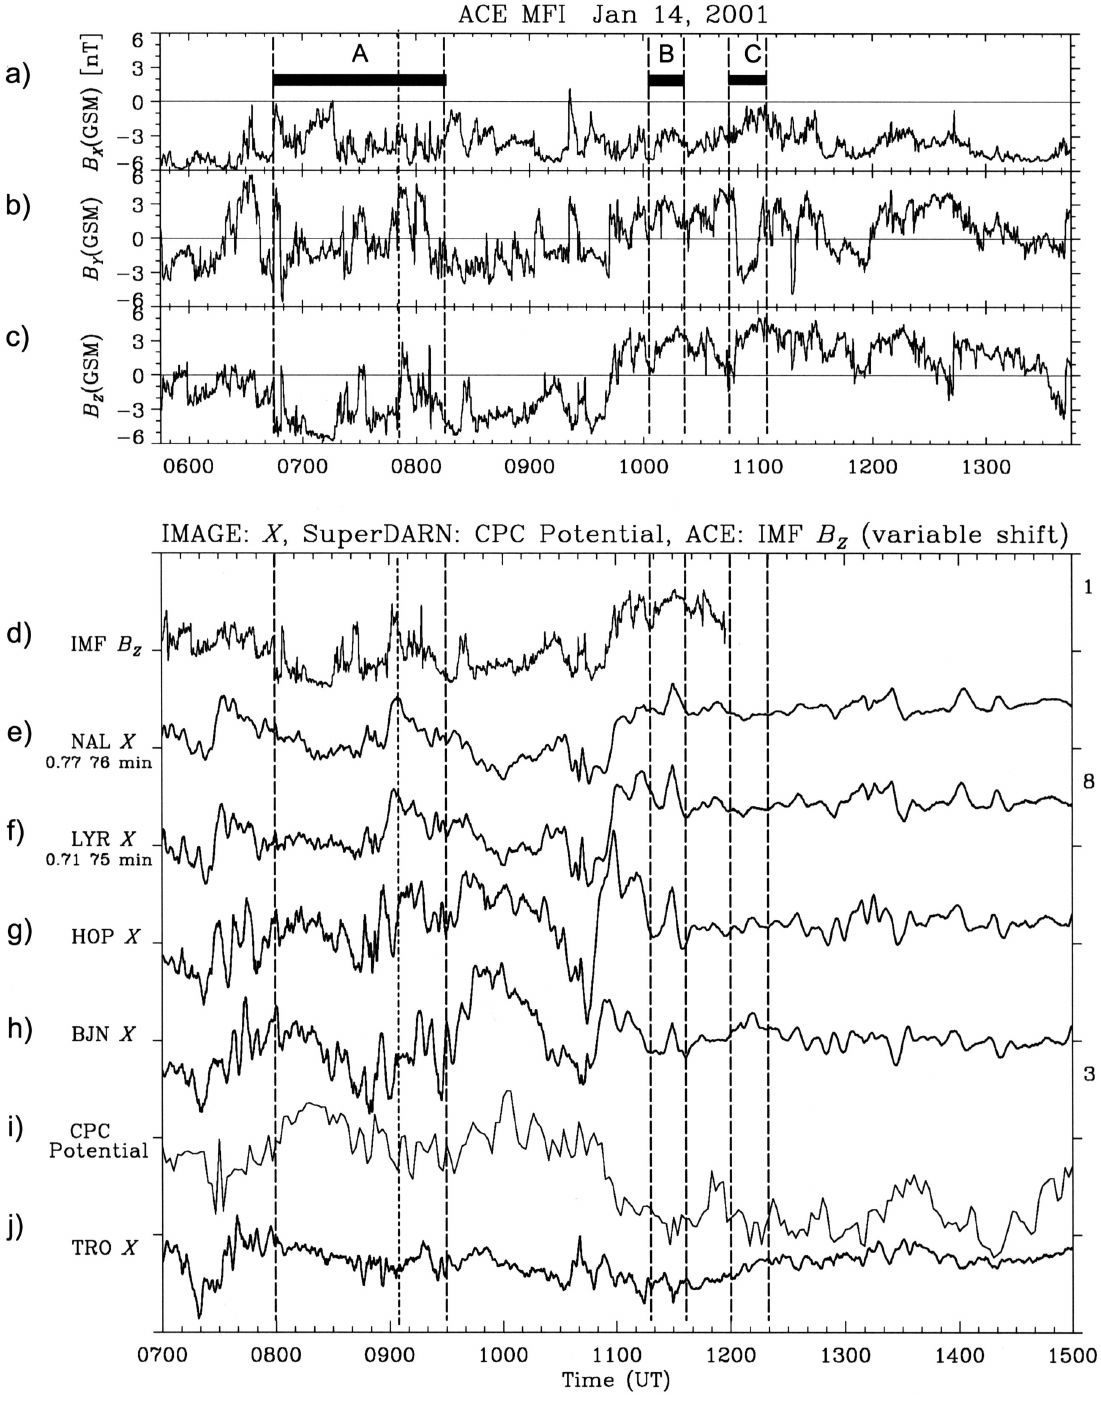
Fig. 3. (a) to (c) The components B X , B Y and B Z of the interplanetary magnetic field (IMF) in GSM coordinates, as seen by the ACE satellite near to the L1 point. Interval A relates to the present paper, intervals B and C are studied in detail by Lockwood et al. (2001a, this issue). (d) The IMF B Z component shown in 3a, but here lagged by the optimum propagation delay from ACE to the dayside ionosphere of 75min. Also shown on this time axis are the X components (northward) of the perturbation to the geomagnetic field seen by 5 magnetometers of the IMAGE chain at (e) Ny ˚Alesund (NAL), (f) Longyearbyen (LYR), (g) Hopen (HOP), (h) Bear Island (BJO) and (j) Tromsø (TRO). Panel (i) shows the transpolar voltage derived from a convection model fit to the SuperDARN data. Allowing for the lag of 75min., intervals A, B and C correspond to 8:00–9:30UT, 11:19–11:27UT and 12:00–12:20UT, respectively, in the dayside